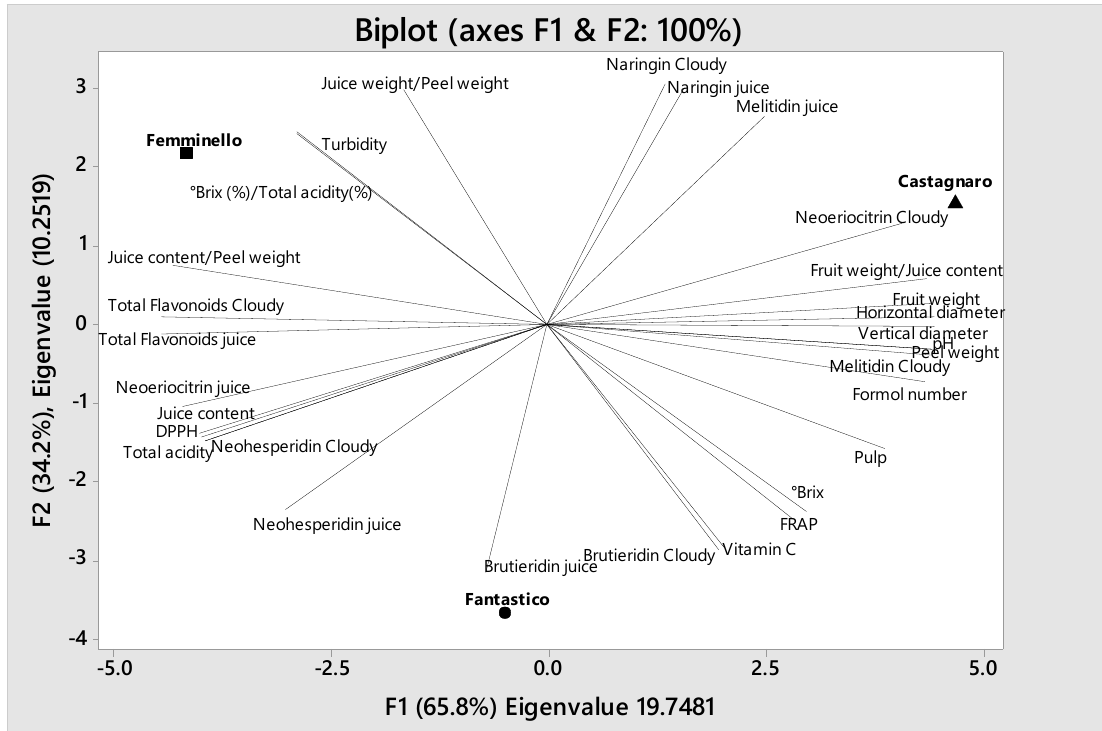
Figure 2. Score plot of the principal component analysis (PCA) performed on the biometrics and the physico-chemical properties of juice and cloudy juice of the three cultivars (Castagnaro, Fantastico and Femminello) of the bergamot fruit ( Citrus bergamia , Risso).